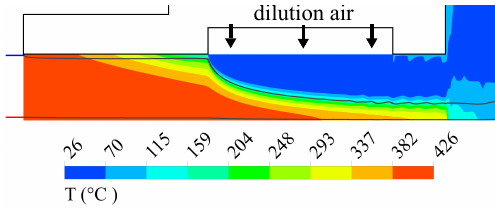
Figure 5. Temperature in the PTD region. The gray lines represent the path lines used in the Lagrangian simulation. Blue and red lines in the beginning of the path lines are the color coding of them. The figure is scaled vertically with a factor of 10.